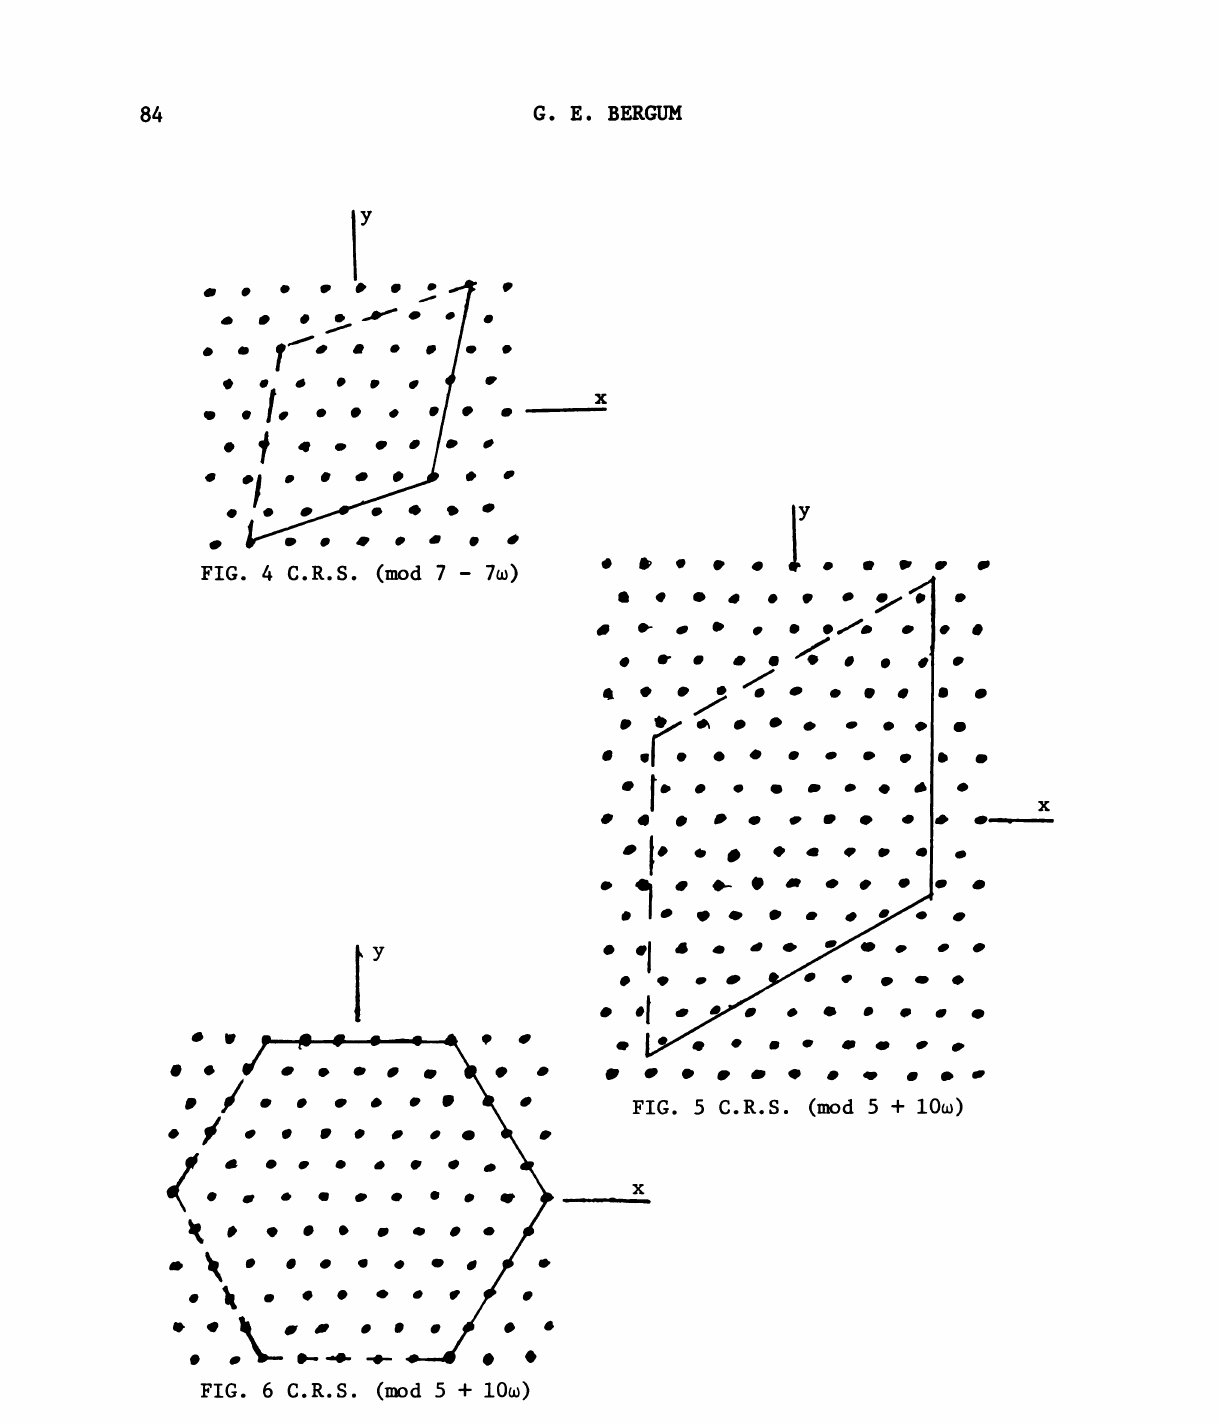
FIG. 6 C.R.S. (mod 5 +